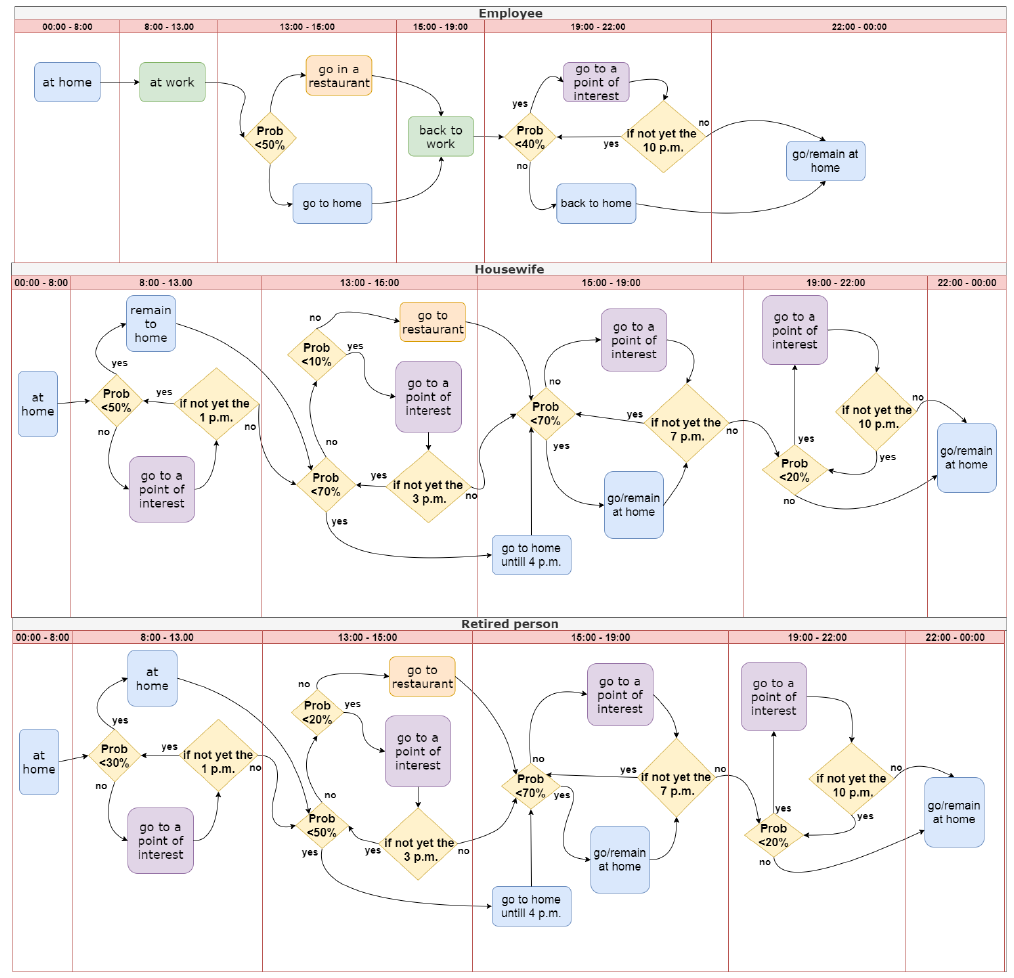
Figure 3. Diagram of human behavior for the different types of